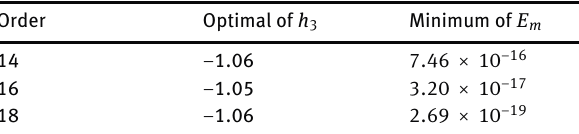
Table 4: Optimal value of h 3 at different order of approximations Order